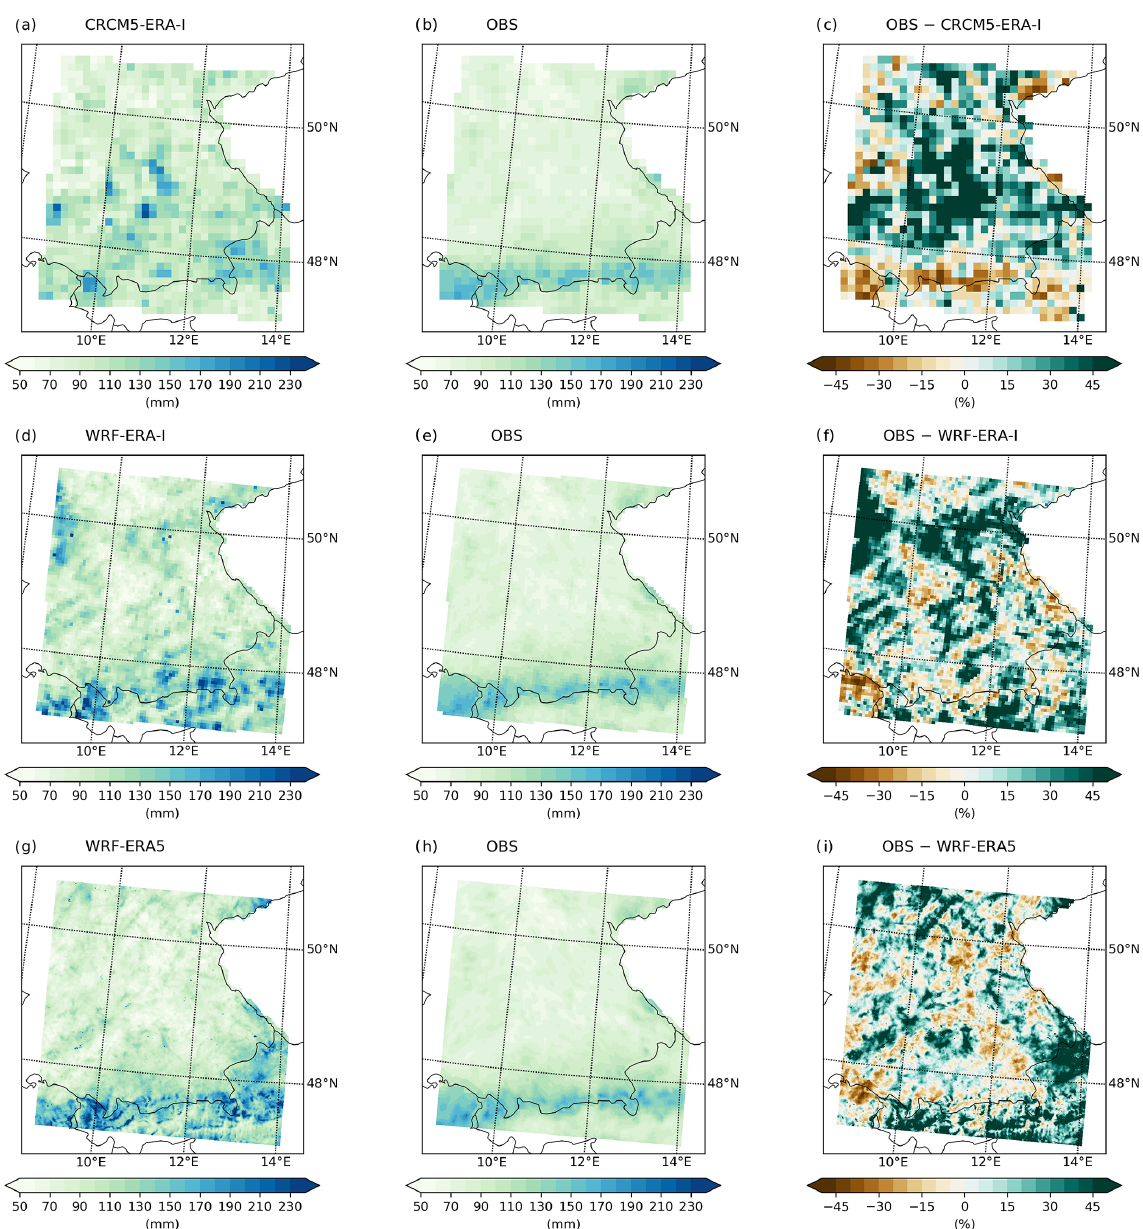
Figure 7. The 100-year rainfall return levels applying GEV-LMOM based on CRCM5 ERA-Interim (a) , WRF ERA-Interim (d) , and WRF ERA5 (g) . The middle column (b, e, h) shows the observational product bilinearly interpolated to the respective climate model grid. The right column (c, f, i) provides the percentage difference calculated as the climate model return level minus the observational return